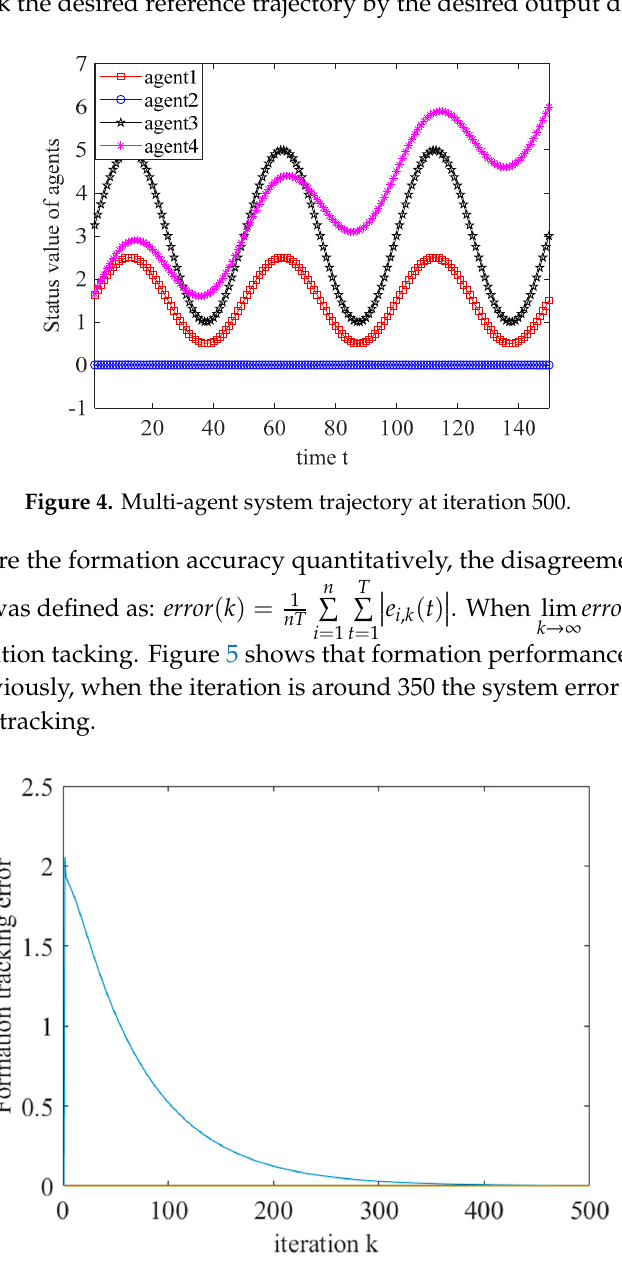
Table 3. Convergence condition parameter. 𝑄 (cid:2869) = 0.514